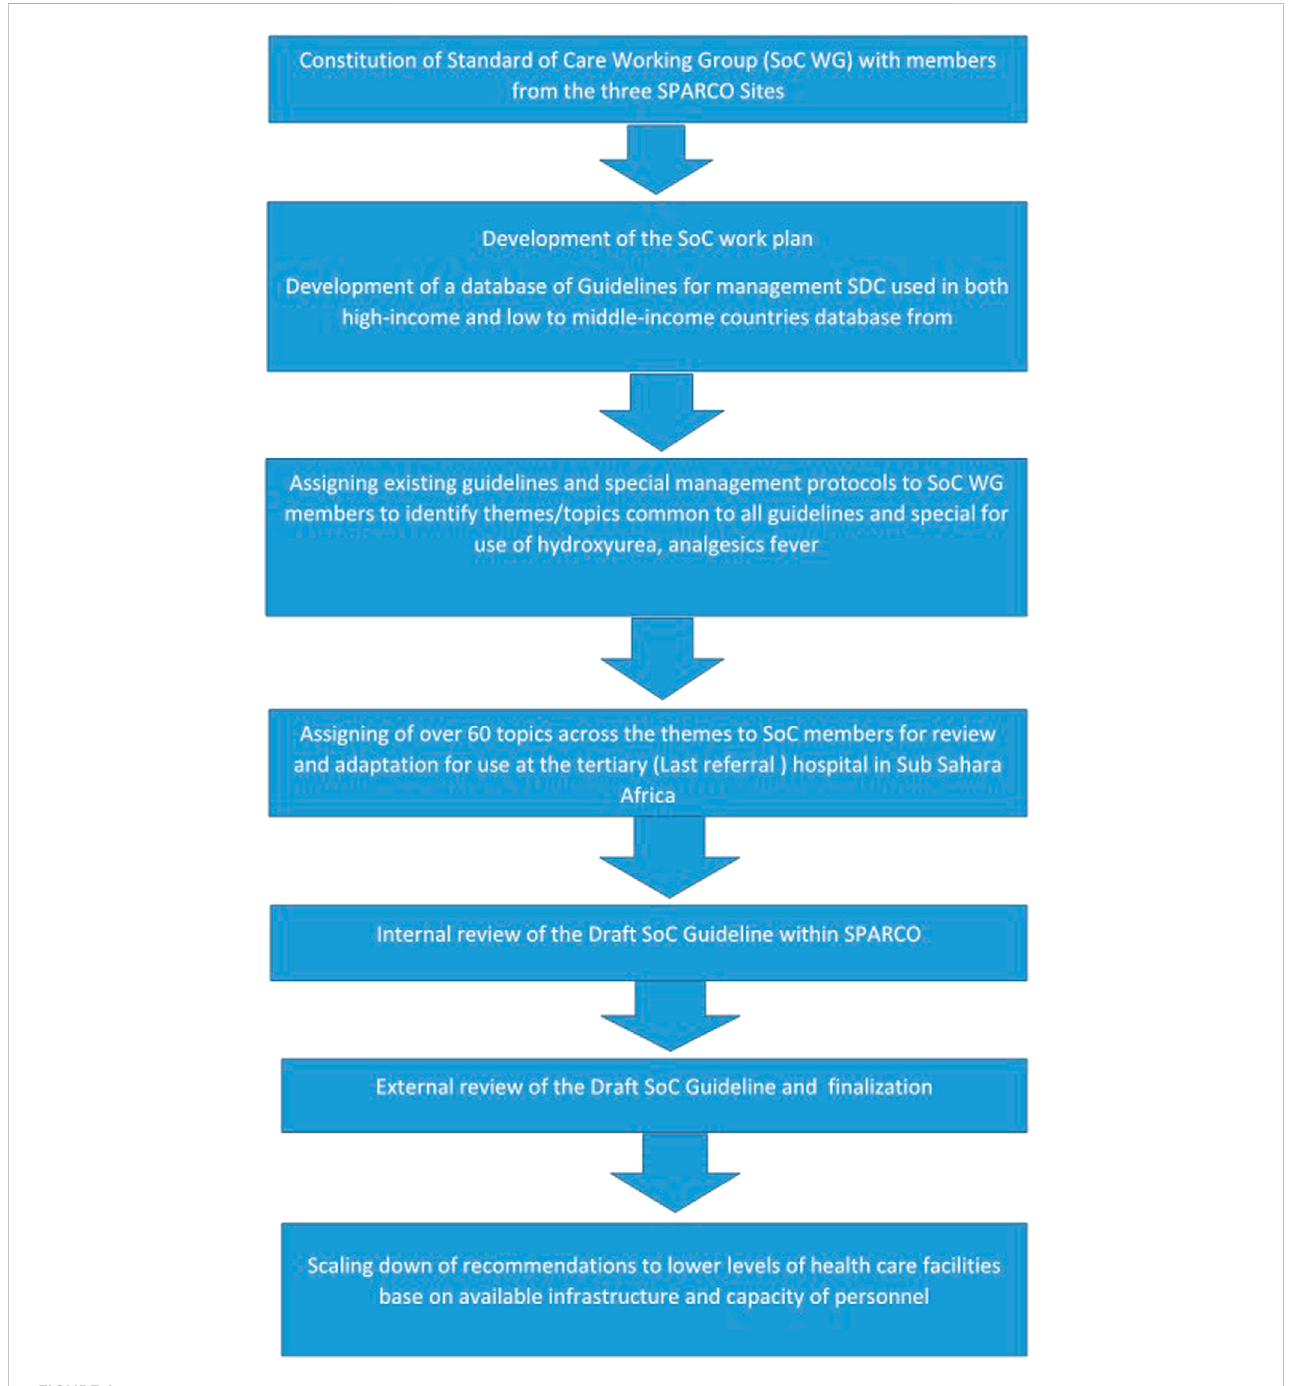
Graphical presentation of the process of development of the standard of care